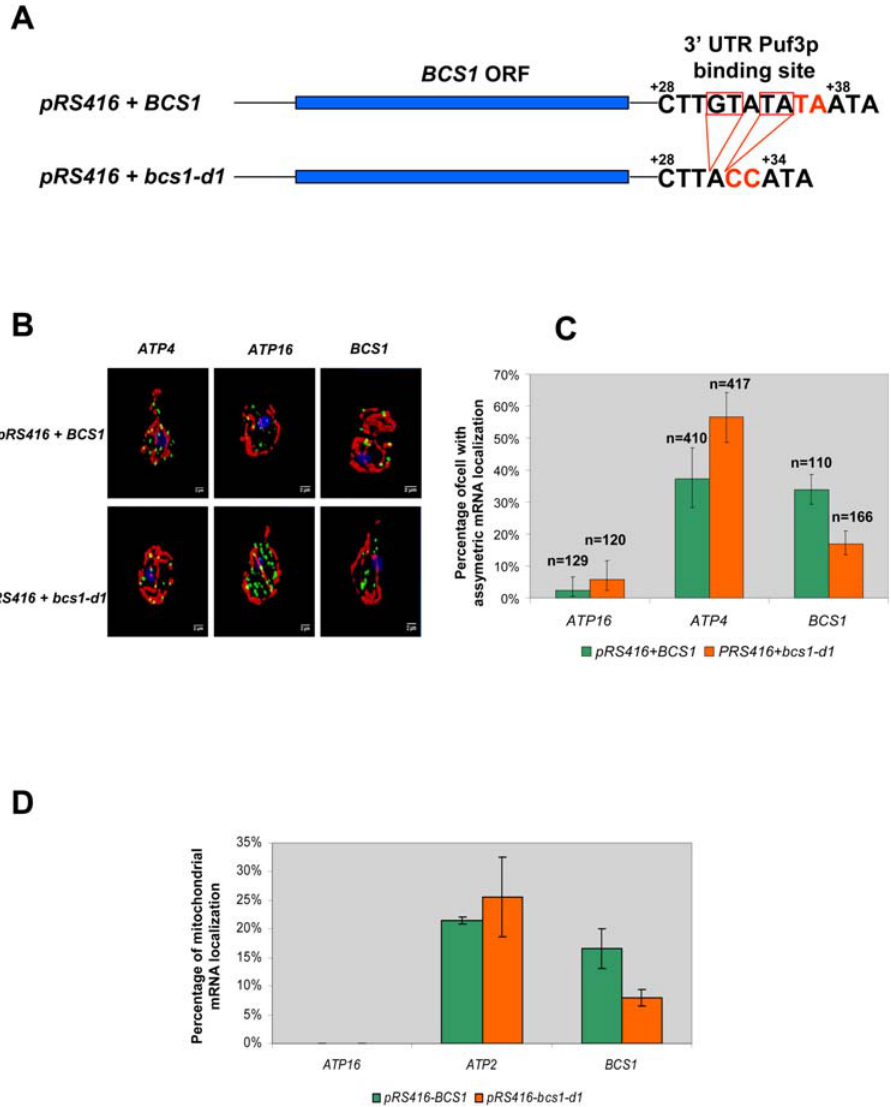
Figure 2. Mutation of the BCS1 Puf3p binding site affects its mRNA mitochondrial localization. A: Six of the ten nucleotides of the putative BCS1 Puf3p binding site have been deleted (red frame) or substituted (red letters) on pRS416 centromeric plasmid carrying BCS1 ORF and its own promoter (A generous gift of G. Dujardin). A bcs1 deleted strain has been transformed by either the plasmid carrying the wild type BCS1 gene (pRS416 + BCS1 ) or a plasmid containing the mutated bcs1 allele (pRS416 + bcs1-d1 ). B: FISH analysis of strain carrying WT or mutated BCS1 plasmids. Five fluorescent probes specific for mitochondrial ribosomal RNA delimit the mitochondrial compartment (red). Specific mRNAs ( ATP4 , ATP16 , BCS1 ) were labeled with specific sets of probes(green).The nucleus is stained byDAPI (blue). A total number of 410 cells ( BCS1 ) and 417 cells ( bcs1-d1 ) wereexamined using BCS1 specific FISH probes. At least 100 cells were examined for the ATP16 and ATP4 specific probes. Projections of 3D reconstructions are presented for the mutant and wild type cells and the 3 different FISH probes. C: Quantification of the mitochondria/mRNA colocalization rate from the FISH experiment has been done using Corsen software (see Material and Methods) and presented in this histogram. The number of cell used for quantification is presented on top of each bar. Corsen allows the calculation of the percentage of cells showing significant mRNA asymmetric localization to the vicinity of mitochondria. Calculation was done in cells expressing WT ( pRS416 + BCS1 ) or mutant ( pRS416 + bcs1-d1 ) BSC1 alleles for ATP4 , ATP16 and BCS1 mRNAs. For each measure a confident interval is calculated based on a binomial distribution. D: RT-quantitative PCR quantification of mRNAs associated with mitochondrial fraction in cells expressing WT ( pRS416 + BCS1 ) or mutant ( pRS416 + bcs1-d1 ) BCS1 alleles. Total and mitochondrial fraction RNAs were extracted as in Material and Methods. The real time quantification is done according to Garcia et al. (12). Each measure was made in triplicate and two independent quantitative PCR have been performed allowing the calculation of a standard deviation presented on the histogram. doi:10.1371/journal.pone.0002293.g002 these situations (Figure 4B, class A modules) is easy to explain two opposite effects on the MLR values of functional modules (Figure 4A). In D puf3 strain, modules involved in translation because the corresponding modules contain mostly class I genes, (ribosomal proteins, translation regulators etc.) and in the assembly which have at least one PUF3 motif in their 3’UTR. On the other of respiratory chain complexes (RCCasm1 to 5) had lower average hand, the increase in the MLR value of class B modules may result from an indirect effect due to the absence of PUF3, resulting in an MLR values whereas metabolic modules (TCA, iTCA, branched amino acids etc.) had higher average MLR values. The first of imbalance in the mRNA-binding protein populations. This is in